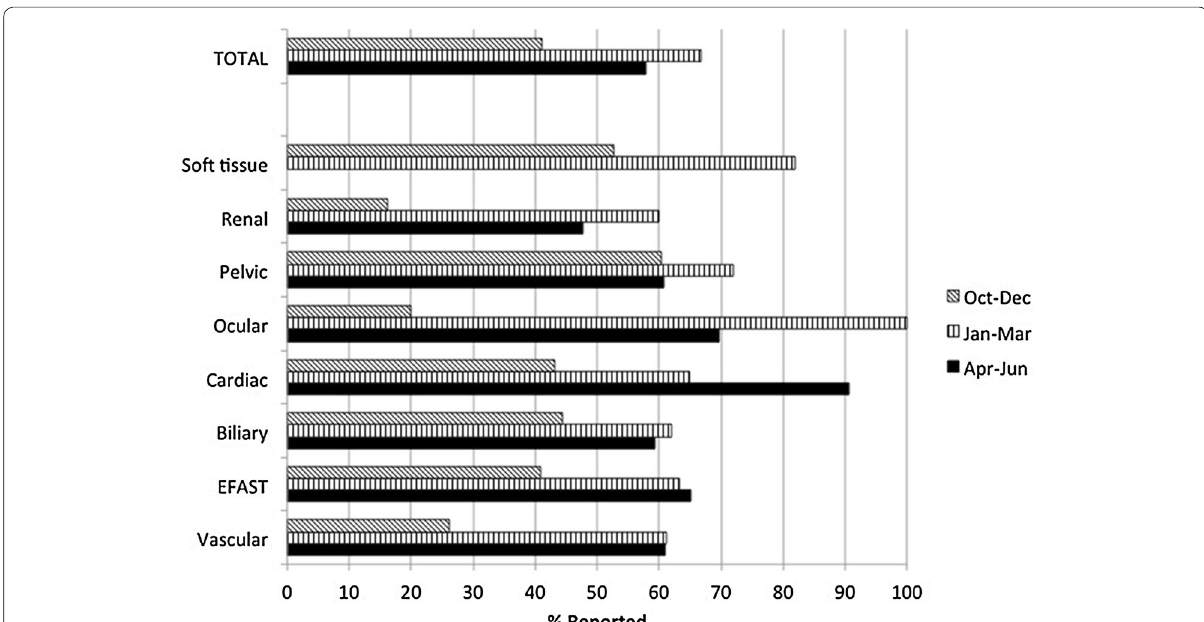
Fig. 2 The percentage of scans reported to the medical coders in the pre- and two 3-month post-intervention periods. X-axis represents the percentage of POC u/s scans documented and reported for coding ( dark slanted hashed bar pre-intervention data; vertical hashed bar first post-